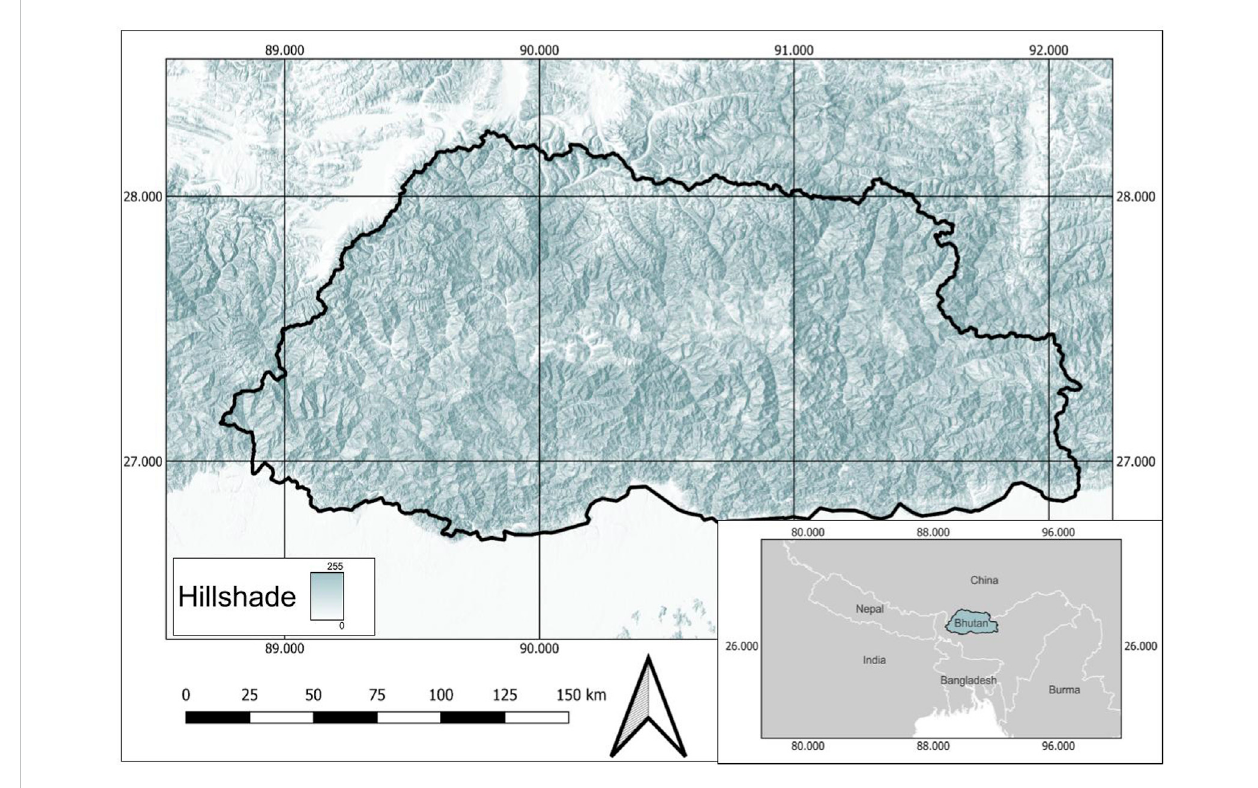
FIGURE 1 Study area map of the Kingdom of